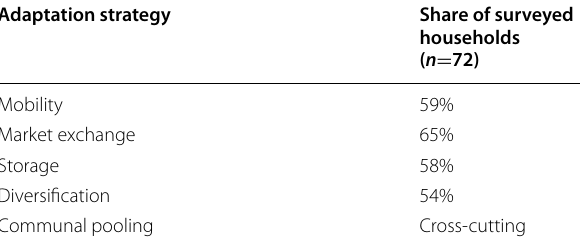
engagement in overall